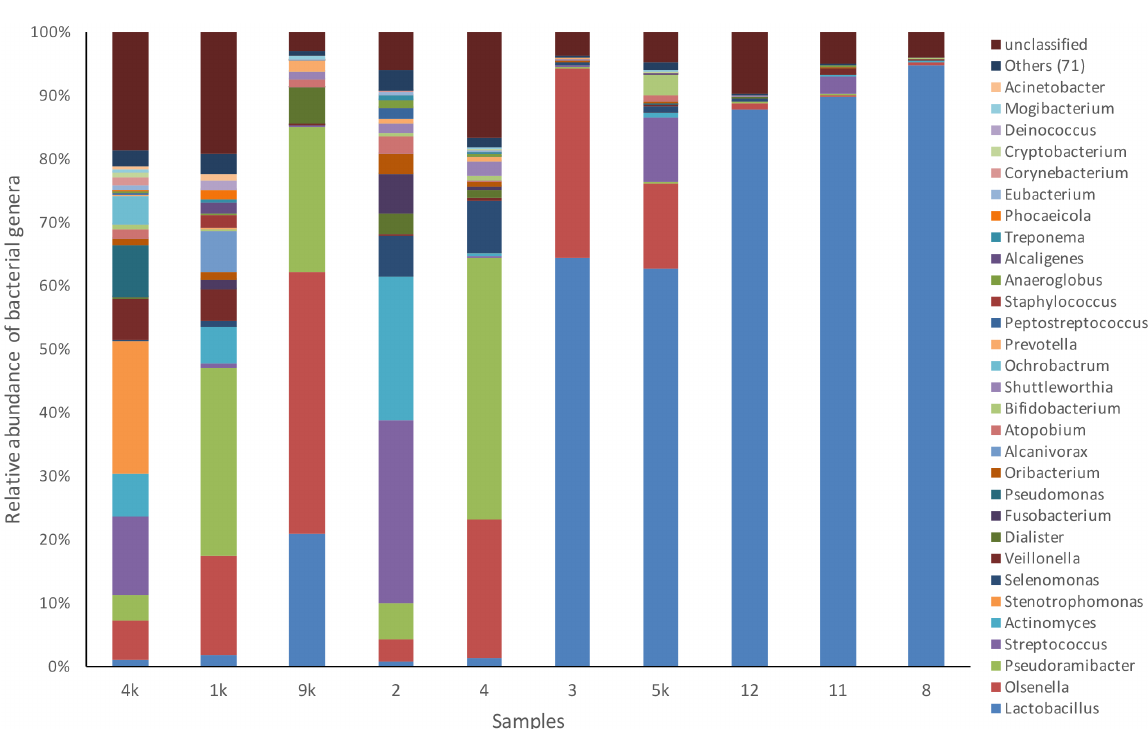
Fig 5. Relative abundance of the top 30 most abundant bacterial genera in each one of the 10 deep caries